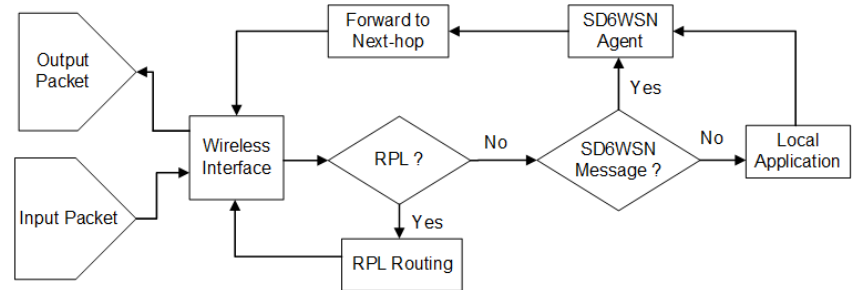
Figure 6. Packet forwarding procedure.